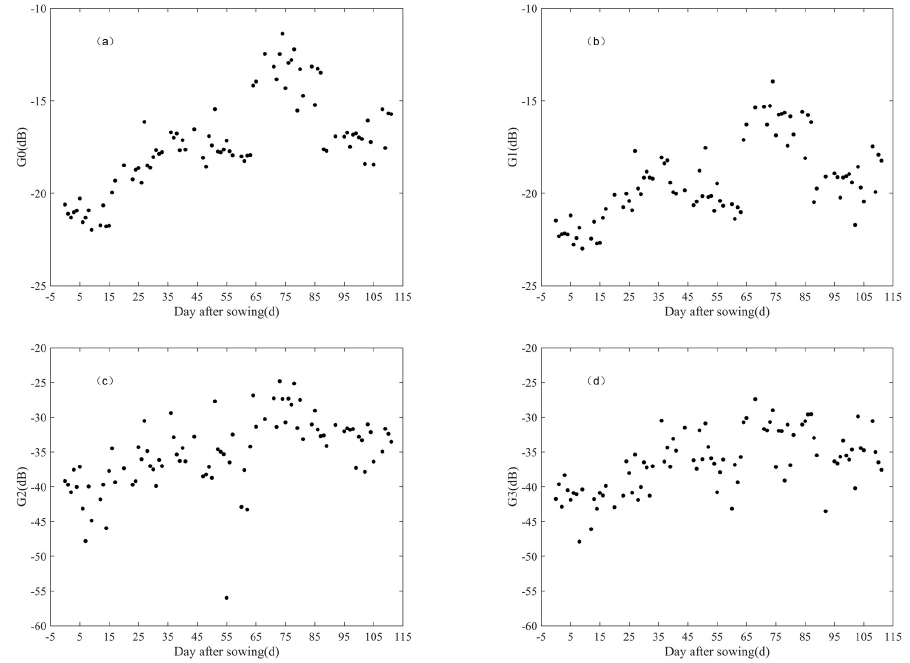
Figure 5. Evolution of the Group2 Stokes parameters versus oilseed rape phenology.